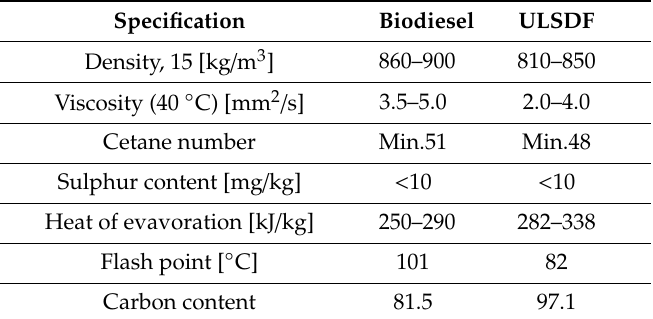
Table 2. The ULSDF and biodiesel specifications.